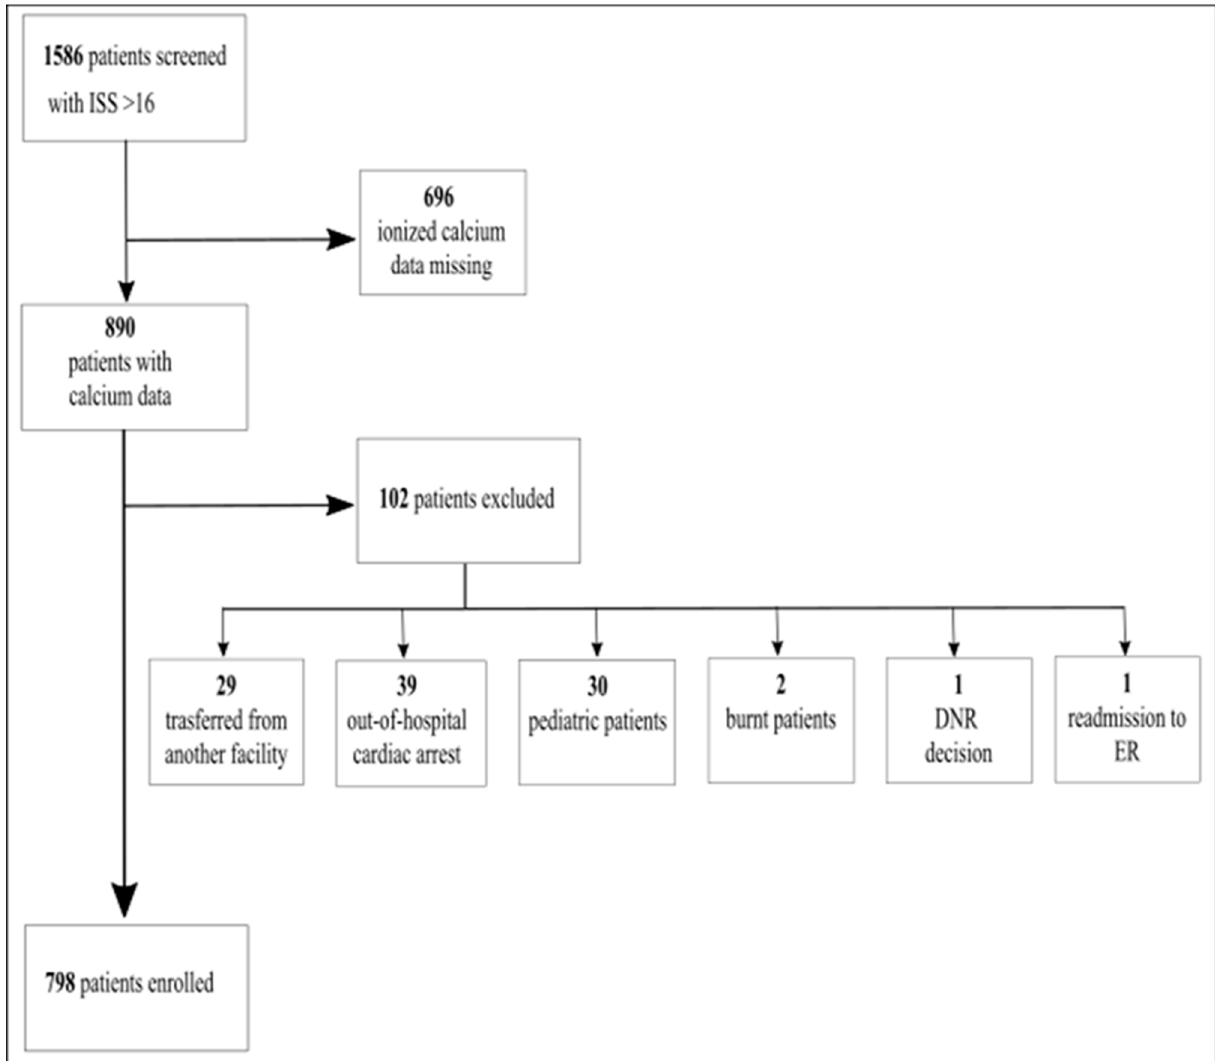
Figure 1. Patient